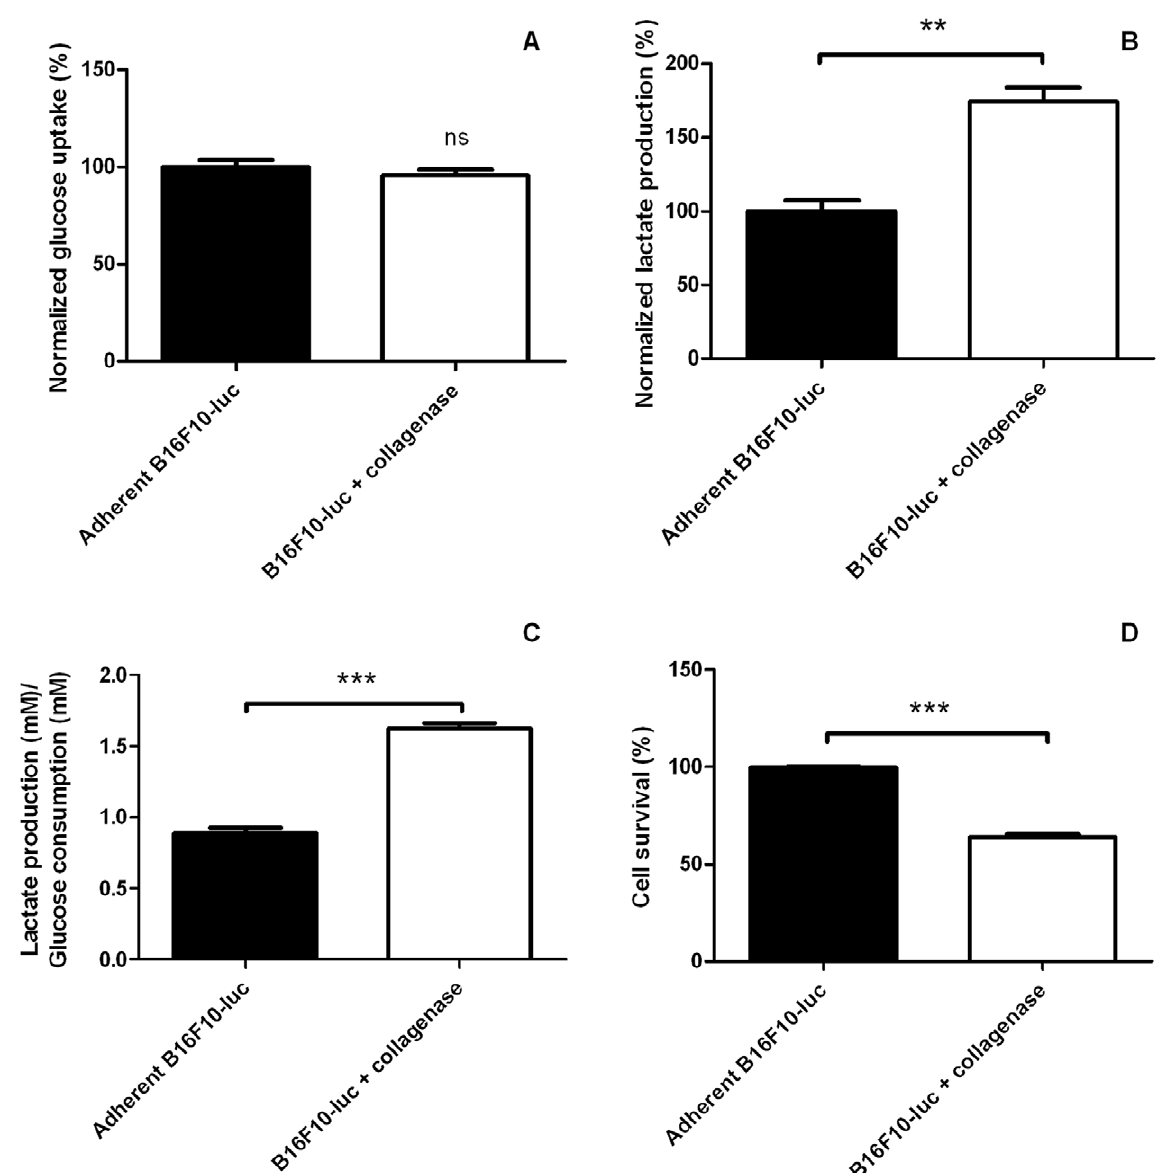
Figure 8. Glucose metabolism in adherent and B16F10-luc detached using collagenase. B16F10-luc seeded on collagen-coated plates and harvested using collagenase (n=3) take up similar levels of glucose (A) but release more important amounts of lactate (B) than adherent cells (n=3). Cell detachment results thus in an increased lactate production/glucose uptake ratio (C). Prolonged detachment (3 hours) affects cell survival (D). Results are sastistically significant (ns, p . 0.05 for A, ** p , 0.01 for B, *** p , 0.001 for C, *** p , 0.001 for D). Data are expressed as means 6 SEM.